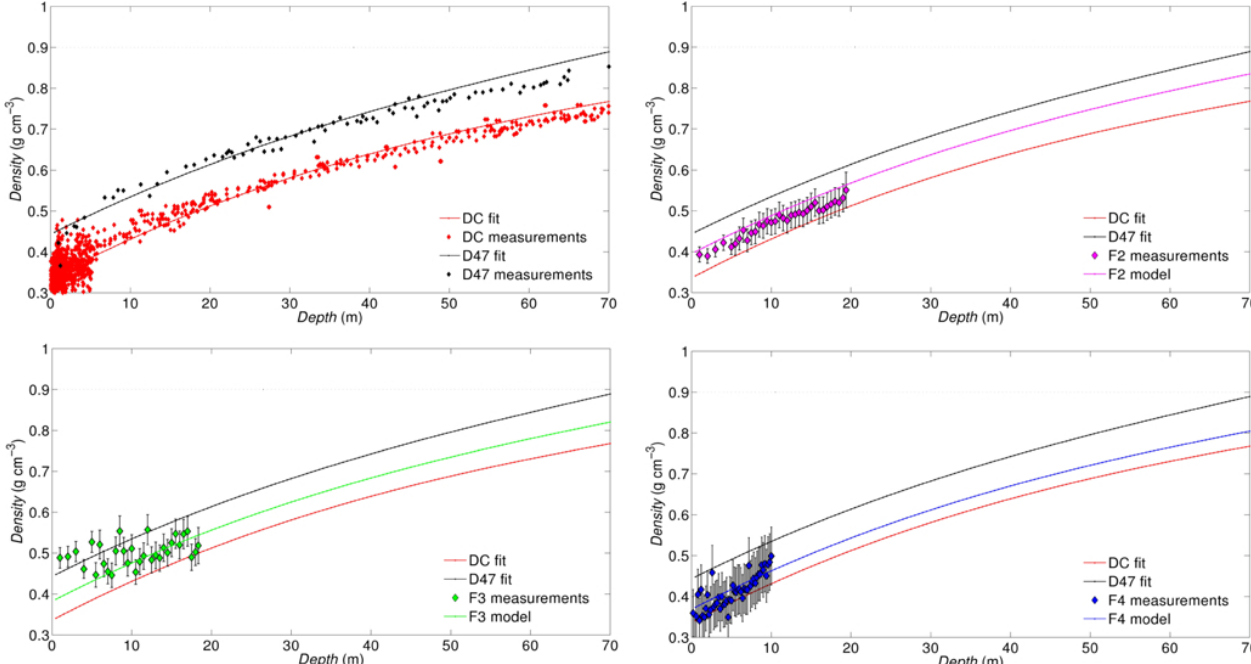
Fig. 2. Selected reflectors labeled R1 to R3 shown on radargram 5. Distance is in metres. The lower panel gives a detail of the reflectors in the middle of the radargram.